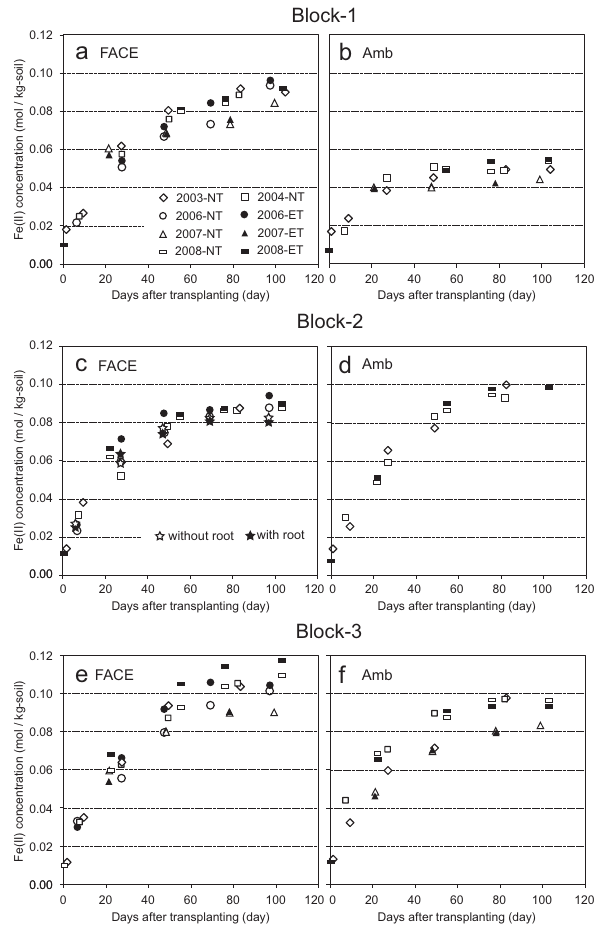
Fig. 3. Seasonal changes in Fe(II) concentration obtained from 3 replication blocks. Different fields are shown separately: (a) , (c) , (e) FACE fields, (b) , (d) , (f) Amb fields. Results from different growing seasons and with different temperature treatments (NT and ET) are shown. In 2006, root-excluded plot was prepared in one of the FACE fields, “without root” in (c).